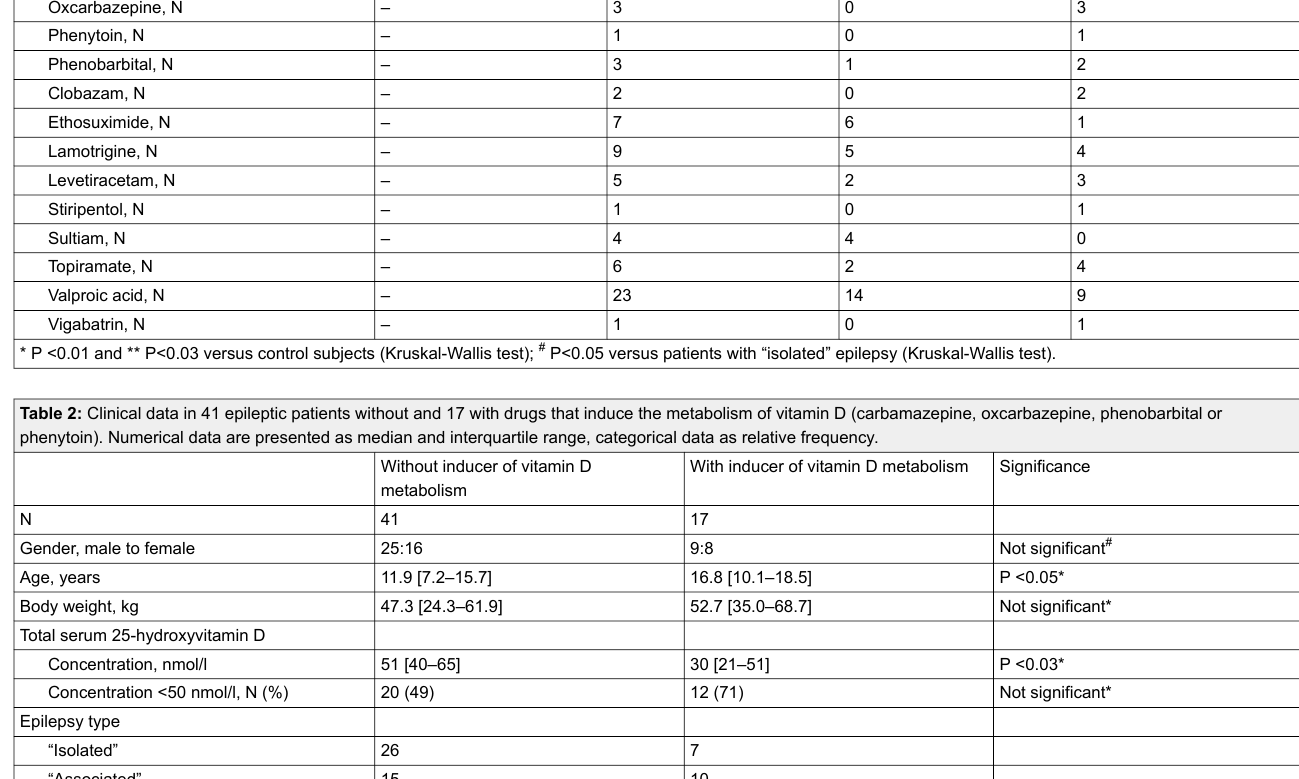
Epilepsy PatientsControl subjects All “Isolated”